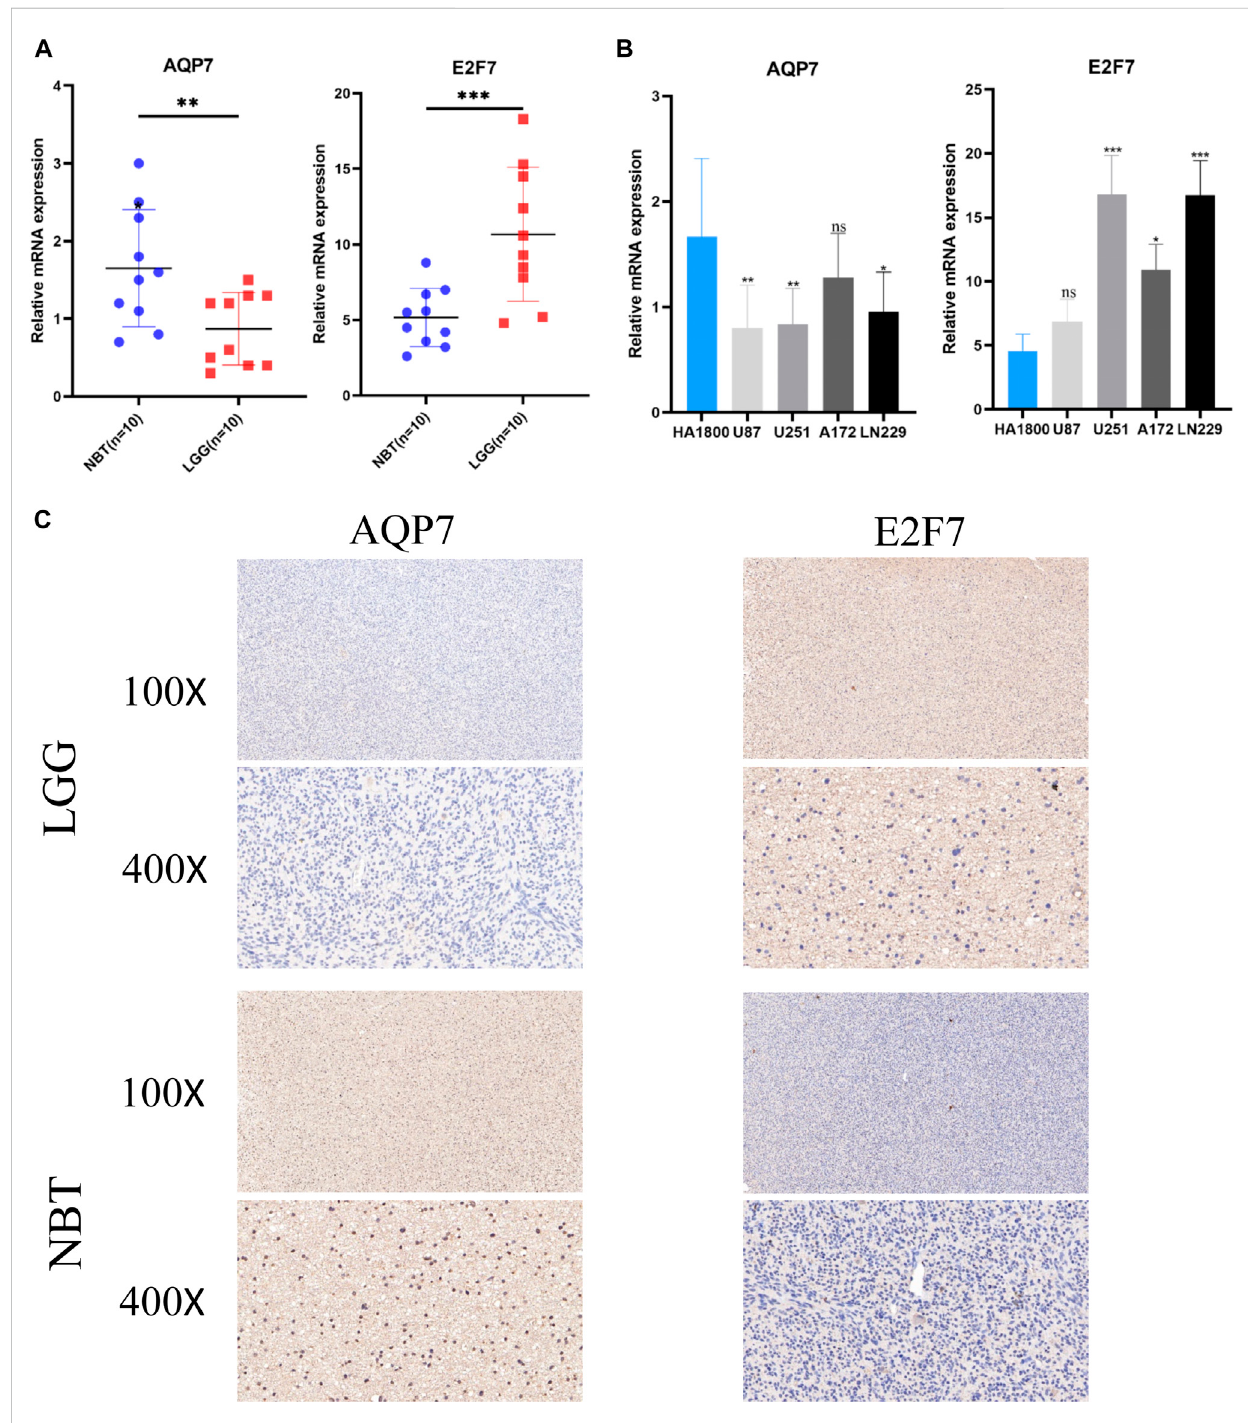
FIGURE 9 Validation of the expression levels of selected super-enhancer related genes. (A) Scatter plots of differential transcript levels between AQP7 and E2F7ingliomacelllinesandnormalhumanastrocytes celllines(HA1800). (B) Scatterplots ofdifferentialtranscriptlevels between AQP7andE2F7inLGG and NBT. (C) The representative IHC staining images of AQP7 and E2F7. LGG low-grade glioma, NBT non-tumor tissues. * p < 0.05, ** p < 0.01, *** p < 0.001, and ns No signi fi